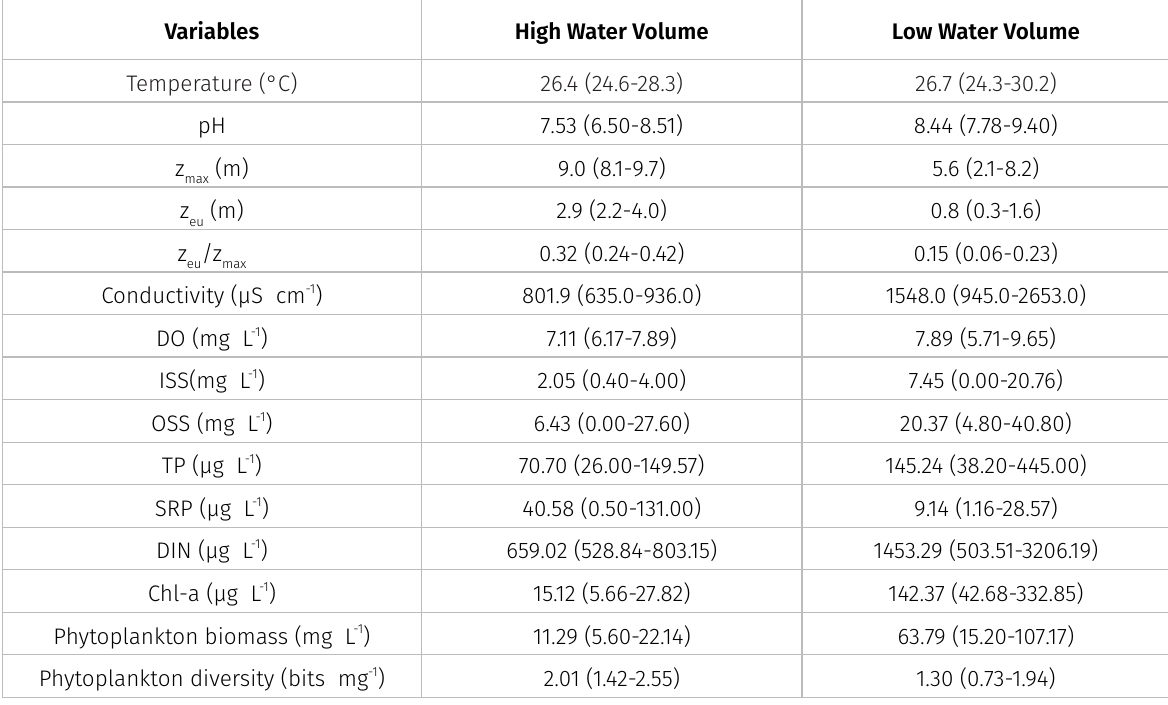
Table I. Descriptive statistics (average, minimum and maximum) of the limnological variables studied at Dourado man-made lake during periods identified by water volume.